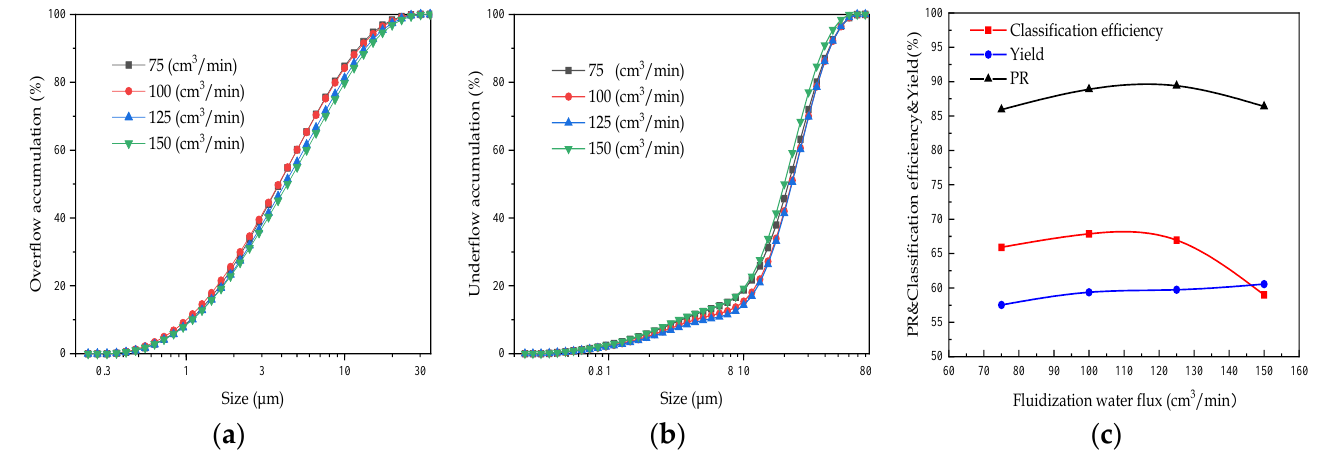
Figure 9. ( a ) Overflow particle size; ( b ) underflow particle size; ( c ) classification index. Experiment on the effect of fluidization water flux condition.